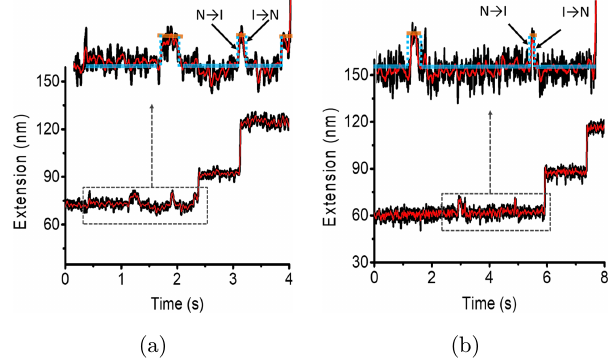
Fig. 3. Intermediate unfolding state during force-increasing process with slow loading rate of 0.2 pN/s. Before the ¯rst unfolding step of M2 and M3 domains, extension of protein jumps up by step of (cid:3) 5 nm and jumps down to original value for several times. Horizontal lines indicate the native confor- mation (cyan color) and unfolding intermediate state (brown color), and arrows and vertical dotted lines indicate the tran- sition from native conformation to intermediate state ð N ! I Þ and inverse transition ð I ! N Þ . (a) Unfolding step of M2 and M3 domains occurs from this intermediate state. (b) Unfolding step of M2 and M3 domains occurs from the native state of M2 and M3